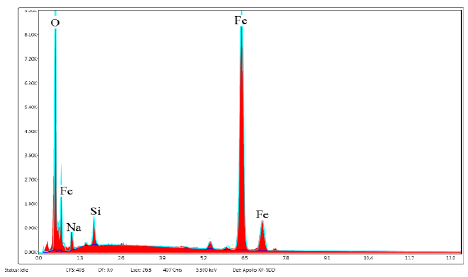
Figure 5. Elemental analysis of the inner rust layer from the powder energy spectrum of the WS0.48Si steel at 120th cycle.